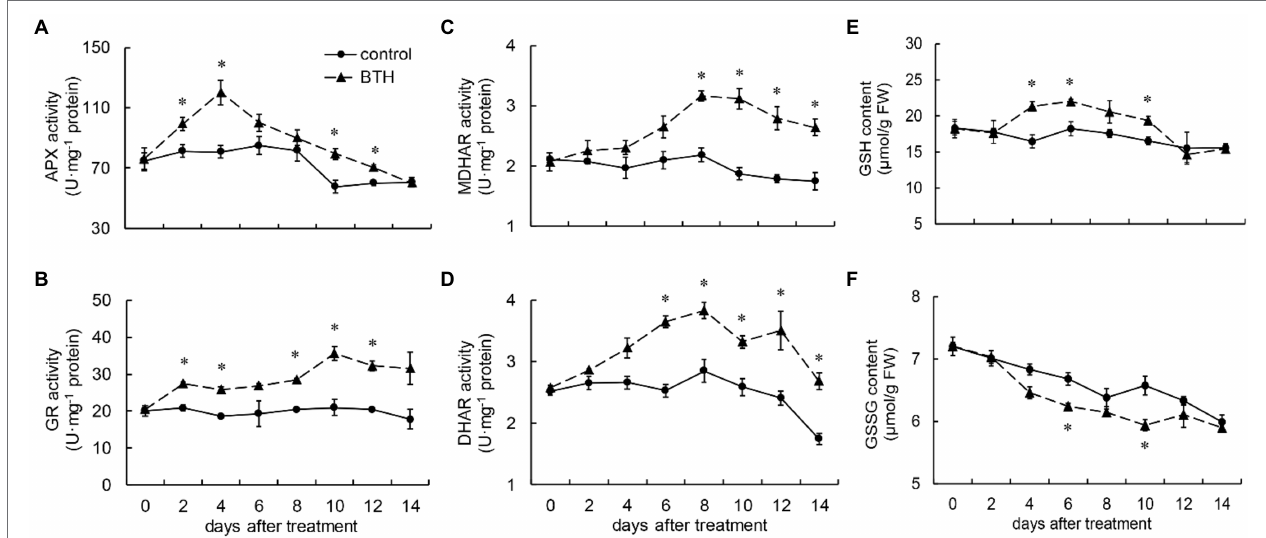
FIGURE 3 | Changes in the activities of ascorbate peroxidase (APX; A ), Glutathione reductase (GR; B ), monodehydroascorbate reductase (MDHAR; C ), and dehydroascorbate reductase (DHAR; D ) and the content of glutathione (GSH; E ) and GSSG (F) in R. roxburghii fruit after BTH treatment during low temperature storage. The significant differences at a level of 0.05 by LSD between the control and BTH-treated fruit are indicated by asterisks (*). Vertical bars represent the standard errors of the means